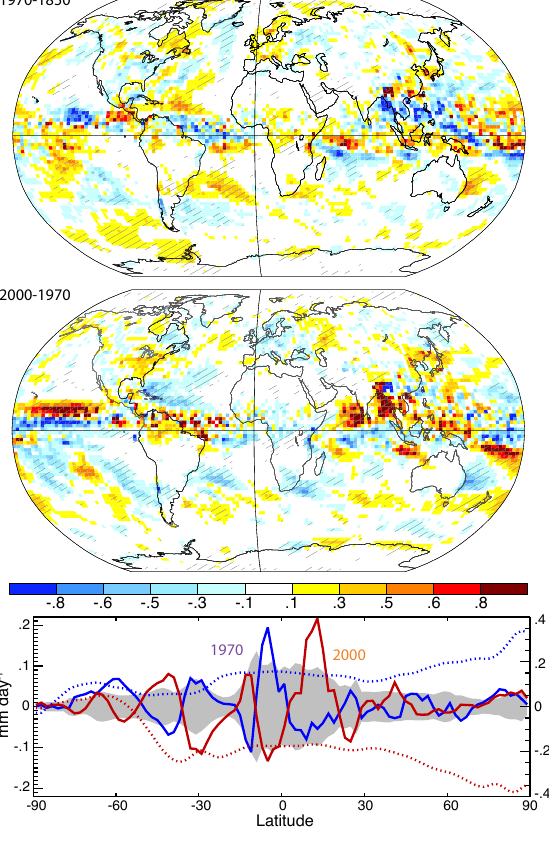
Fig. 26. June–August precipitation changes (mm day − 1 ) in re- sponse to ozone forcing comparing 1970 (1966–1975) with 1850 (1850–1859) and 2000 (1996–2005) with 1970. Hatching in the up- per panels indicates 95% statistical significance for the ensemble mean response relative to the control variability. Solid lines in the bottom panel show the zonal mean precipitation while dotted lines show zonal mean temperature changes at 200hPa. The shaded area indicates the 2-sigma uncertainty range for precipitation